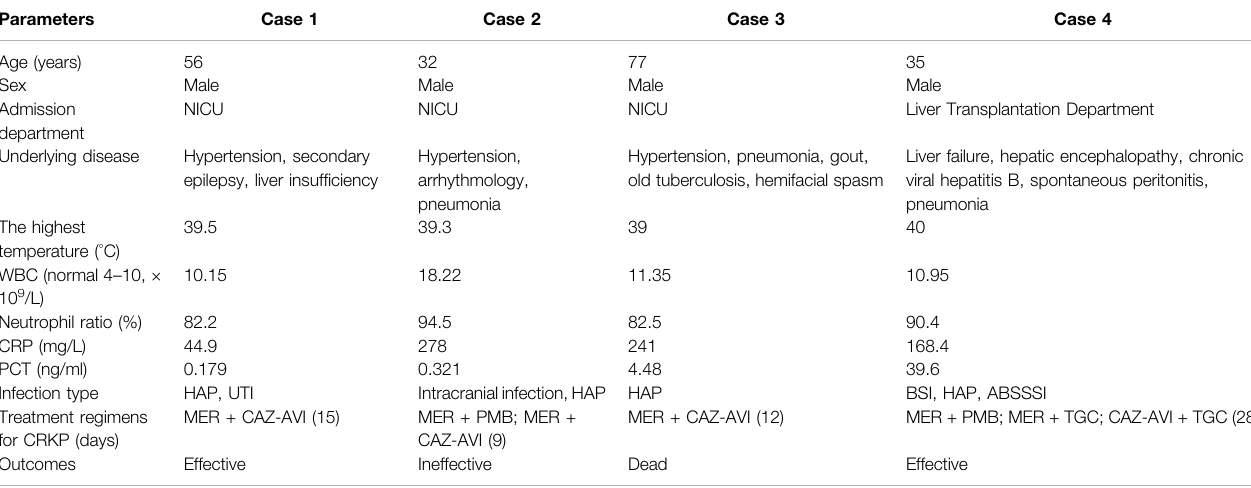
TABLE 1 | Clinical characteristics of patients.